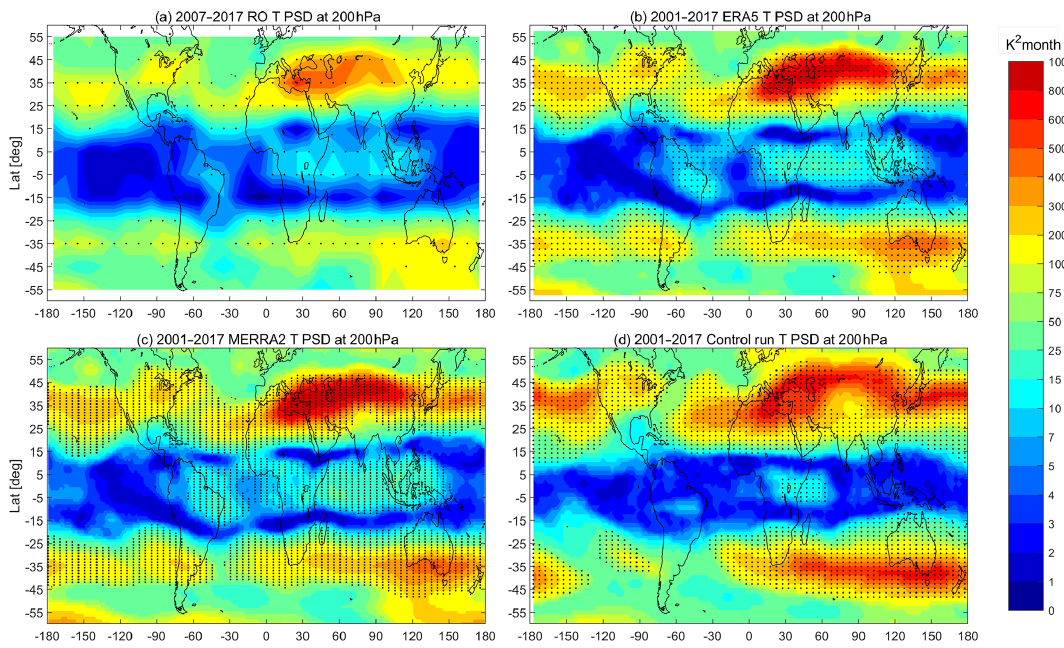
Figure 2. The PSD of SAO based on COSMIC-1 (2007–2017) (a) , ERA5 (2001–2017) (b) , MERRA2 (2001–2017) (c) and model simulation (2001–2017) (d) at 200hPa. The dots mark the significant area at 95%